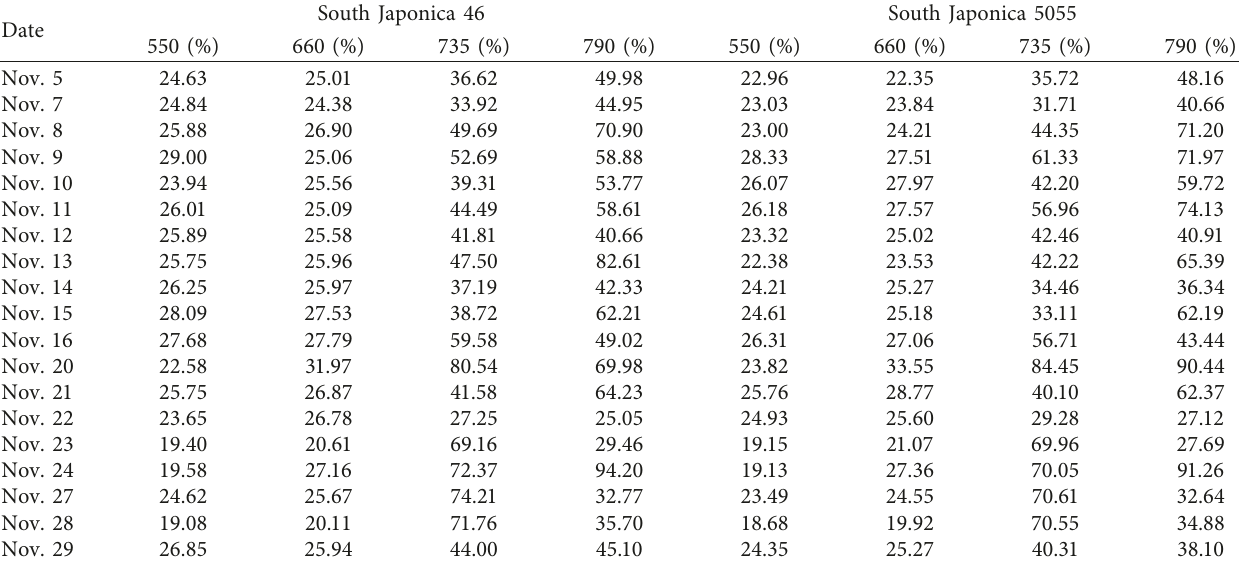
Table 3: Average spectral reflectance at different bands during the trial period.